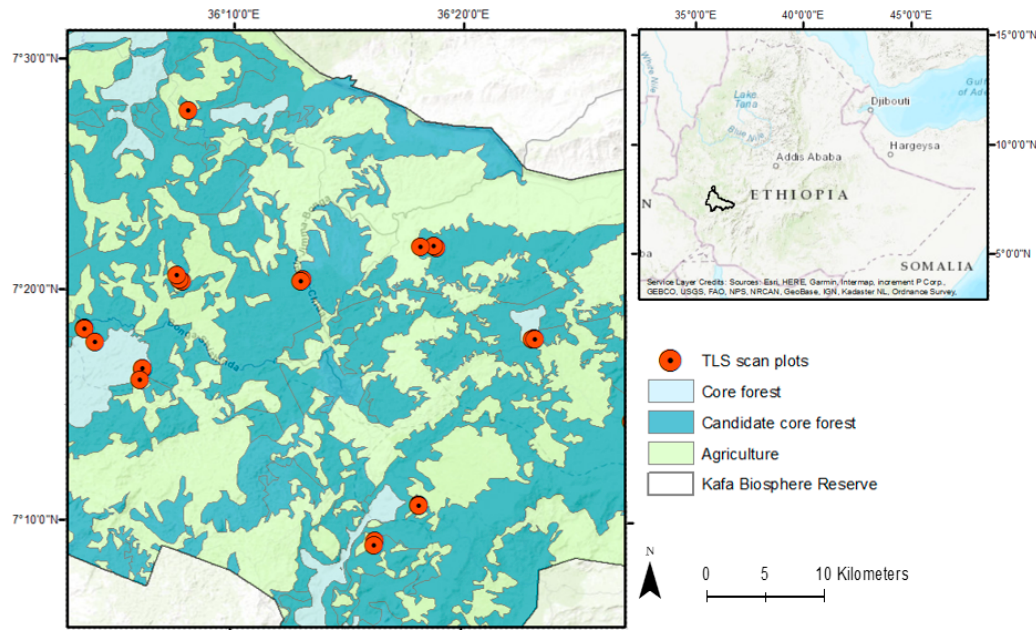
Figure 1. Location of the study area Kafa biosphere reserve in Ethiopia, indicating the field plots ( n = 25) used for this study. Note: Some plots are invisible due to the spatial proximity from mapping scale used.